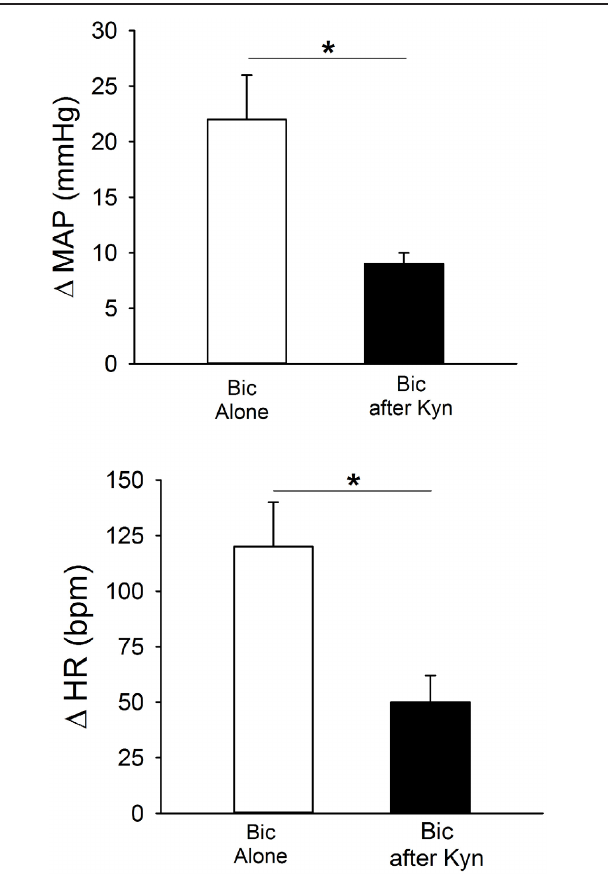
FIGURE 6 | MAP and HR effects of unilateral microinjection of the selective ionotropic glutamate receptor agonist N-methyl-D-aspartic acid (NMDA, 1mM) into the PVN of conscious rats ( n = 4). NMDA was injected before (open bars) and after (filled bars) blockade of NOS with L-NMMA (2mM). NMDA alone produced significant increases in MAP and HR. Pressor responses to NMDA were significantly enhanced by prior injection of L-NMMA ( ∗ p ≤ 0 . 05).